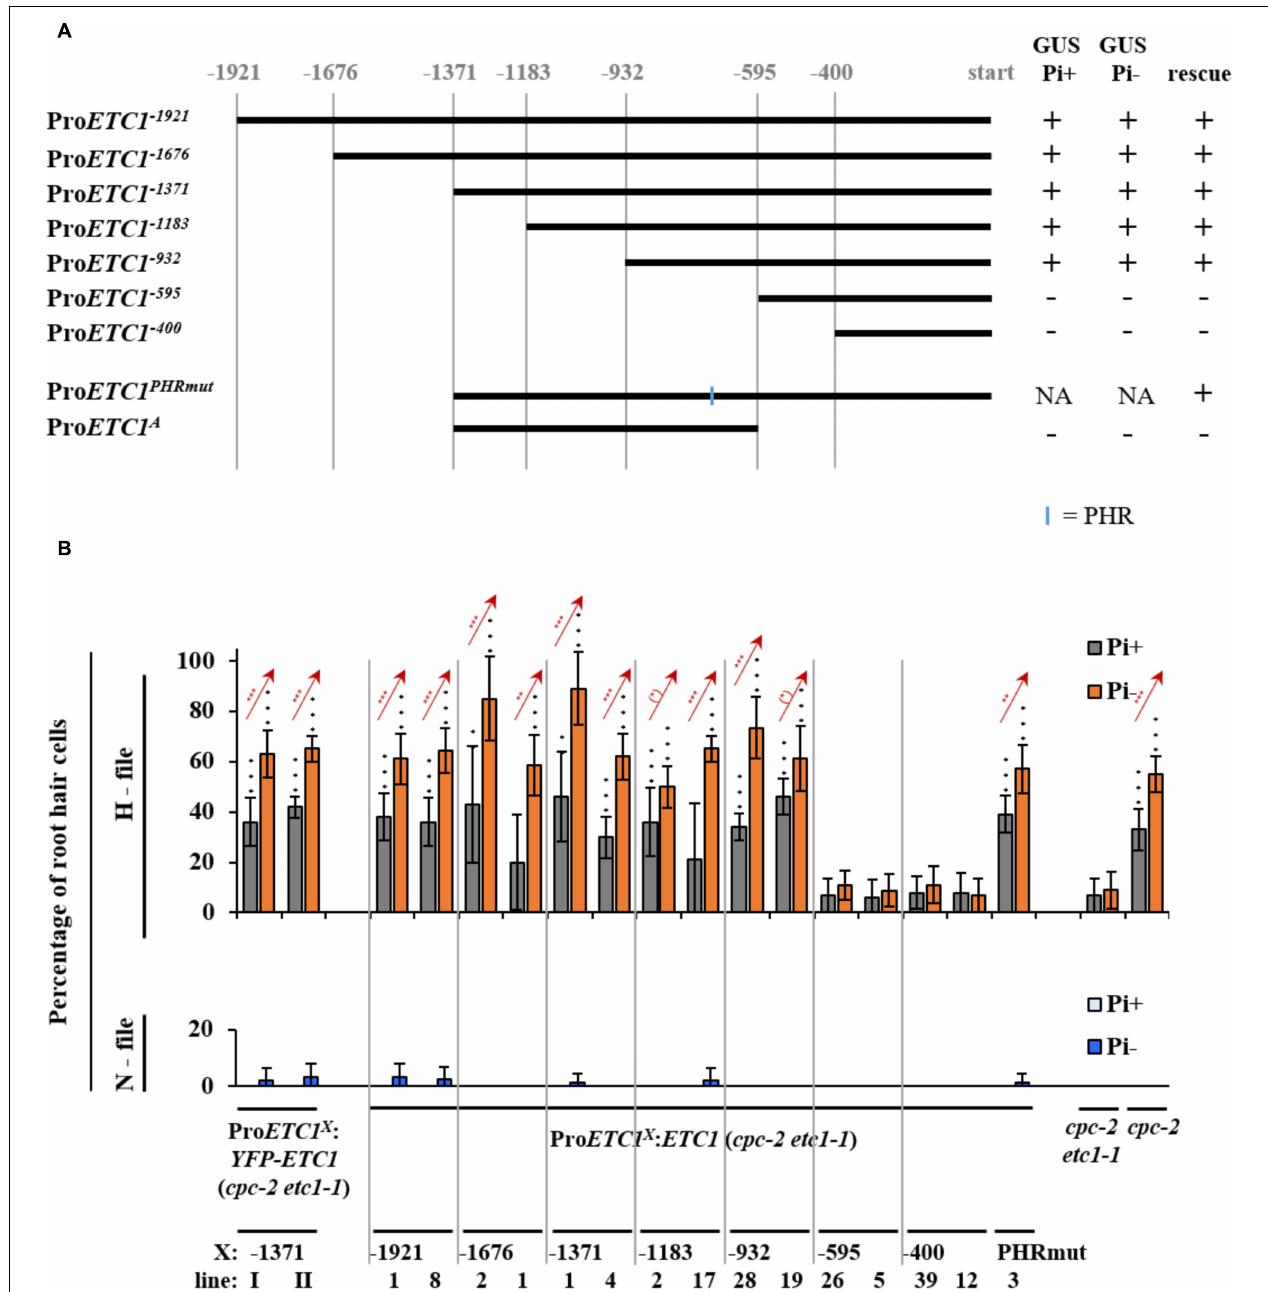
FIGURE 3 | Promoter deletion analysis of ETC1 . (A) Schematic diagram showing a serial deletion of the 5 (cid:48) regulatory region of ETC1 . Vertical lines show the relative position of the fragment with respect to the ETC1 start codon. The blue line indicates the location of the phosphate response binding ( PHR-1 ) site. (B) Rescue analysis of the ETC1 promoter fragments in at least ten plants. Red stars indicate a significant difference between Pi+ and Pi– conditions at ∗ p < 0.5, ∗∗ p < 0.01, ∗∗∗ p < 0.001 (Wilcoxon test). Black stars indicate a significant difference between wild type and mutants at ∗ p < 0.5, ∗∗ p < 0.01, ∗∗∗ p < 0.001 (Wilcoxon test). + Indicates that the construct was able to rescue or was able to drive GUS expression, – indicates that the construct was not able to rescue or was not able to drive GUS expression.